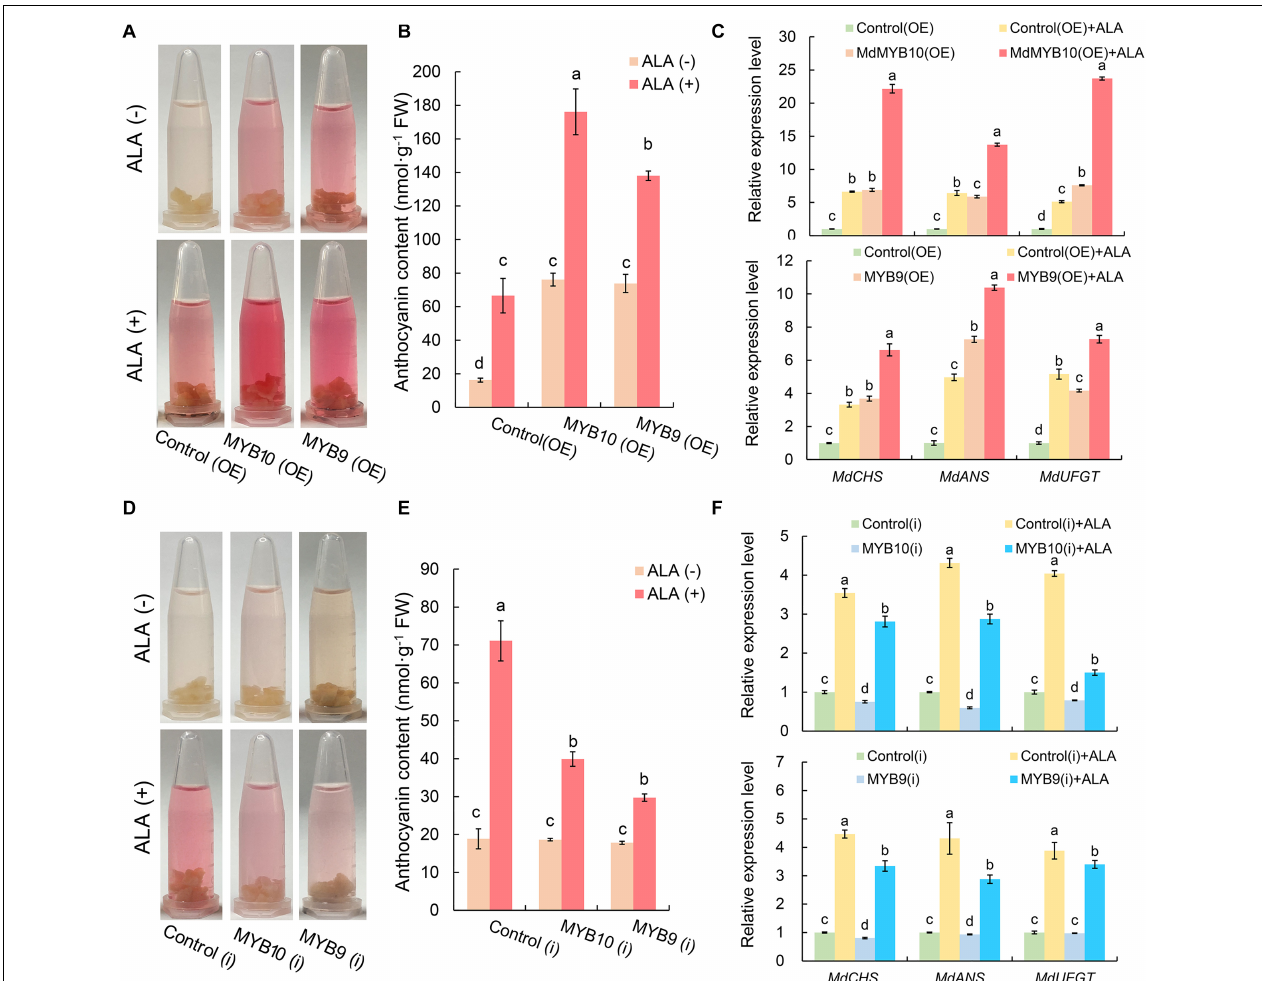
FIGURE 6 | Effect of ALA on coloration level and anthocyanin content as well as the corresponding gene expression in MdMYB10 and MdMYB9 transgenic calli. Color (A) and anthocyanin content (B) in transgenic calli; OE, calli infiltrated with the plasmid for overexpressing of target genes; Control (OE), calli infiltrated with an empty pBI121 vector. (C) The expression of anthocyanin biosynthesis genes in MYB10 (OE) and MYB9 (OE). Color (D) and anthocyanin content (E) in transgenic calli; RNAi, calli infiltrated with the plasmid for silencing of target genes; Control(i), calli infiltrated with an empty pHG2 vector. (F) The expression of anthocyanin biosynthesis genes in MYB10 (i) and MYB9 (i). The different letters in each gene represent significant differences ( p < 0.05).